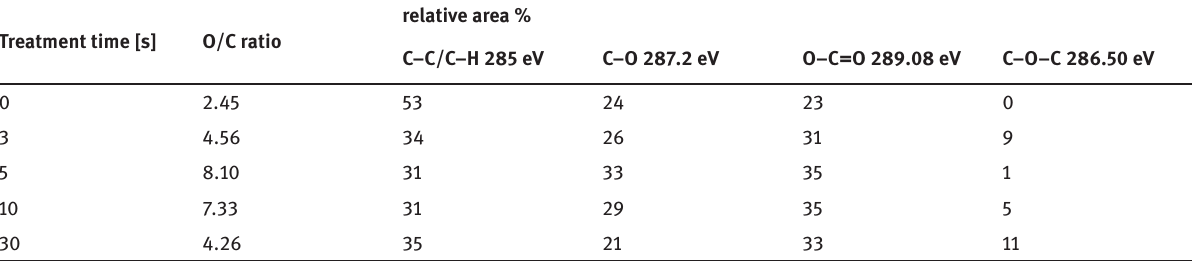
Table 2 : PLA sample treated at 350 W input power.